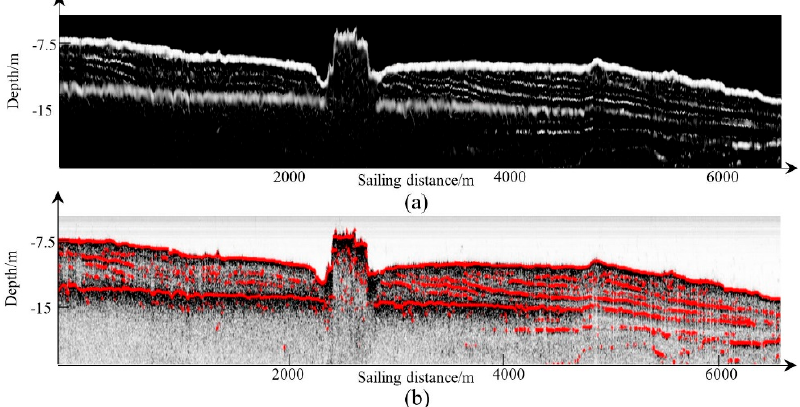
Figure 15. The filtered result and the picked result. ( a ) shows the filtered image using a small σ min . Picking horizons from ( a ), ( b ) shows the superposition of picked horizons and the original SBP image.